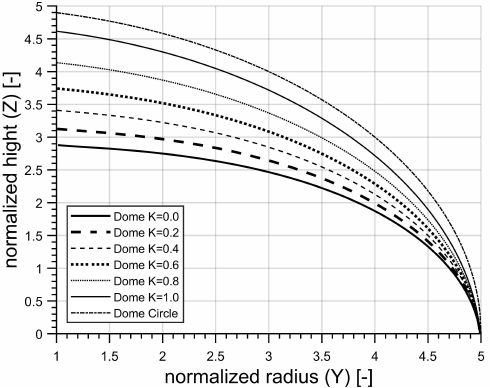
Figure 3. Dome contours generated by our fourth-order Runge–Kutta script. Using Equation (1) introduced above, the winding angle is easily obtained from Y ( ρ ) at each integration step and is plotted for each contour in Figure 4. These winding angles correspond to a Y eq = 4.6 used in the simulations that follow in the next section.